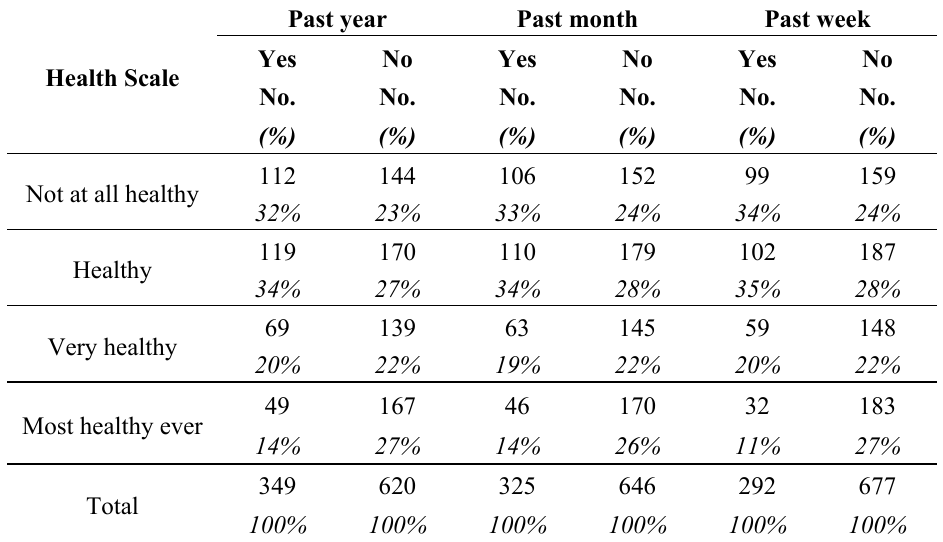
Table 4. Distribution of waterpipe frequency use and participants’ perception of